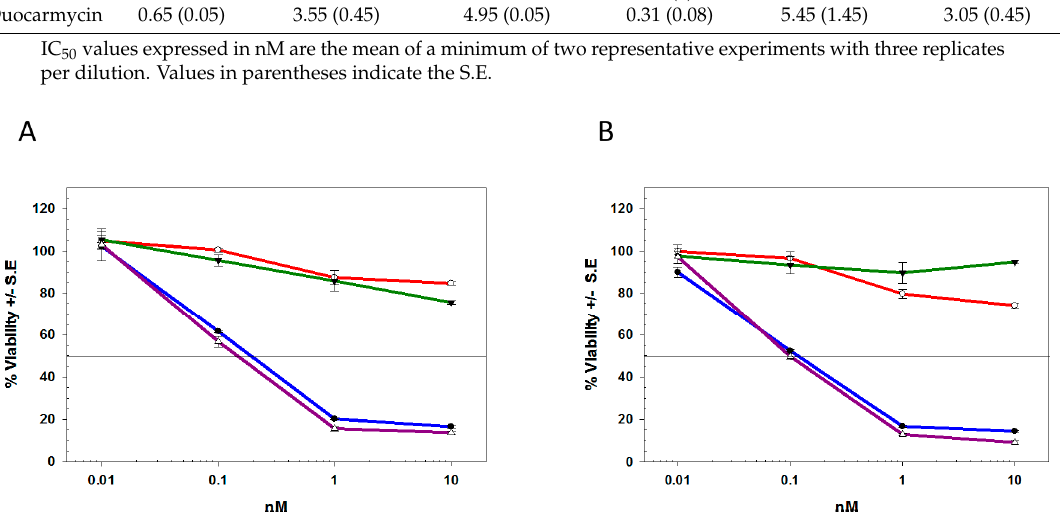
Figure 4. Cytotoxicity of deB-C6.5-diab (blue), T-DM1 (red), T-MMAE (green), and T-deB (purple) against HCC1419 cells surviving T-DM1 ( A ) or T-MMAE ( B ) treatments. Representative examples of two independent experiments.